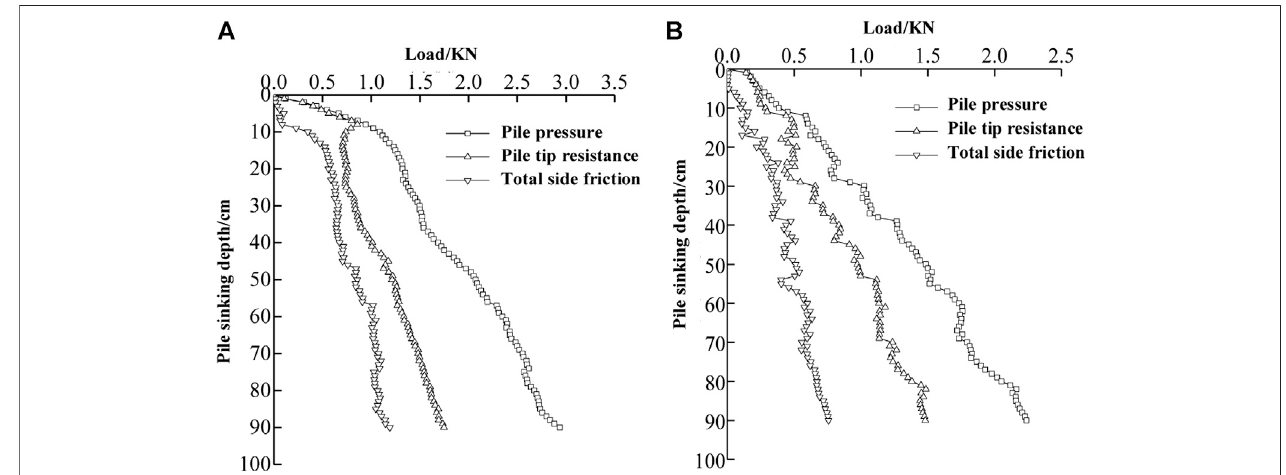
Frontiers in Physics |